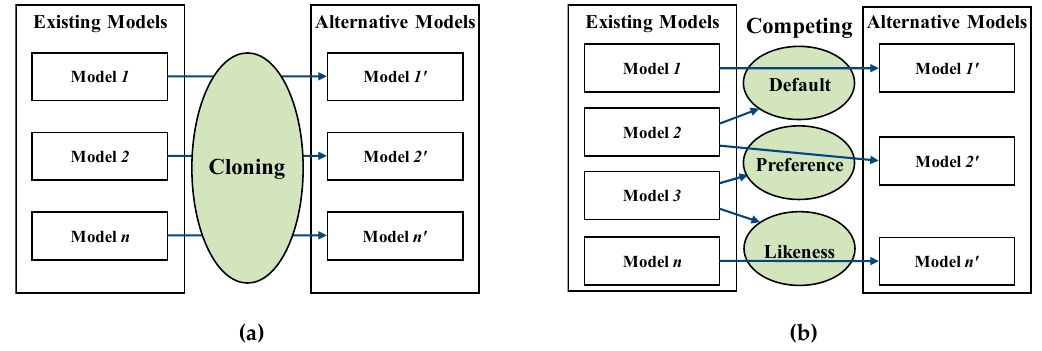
Figure 7. Two methods of transfer learning; ( a ) cloning, ( b ) competing.